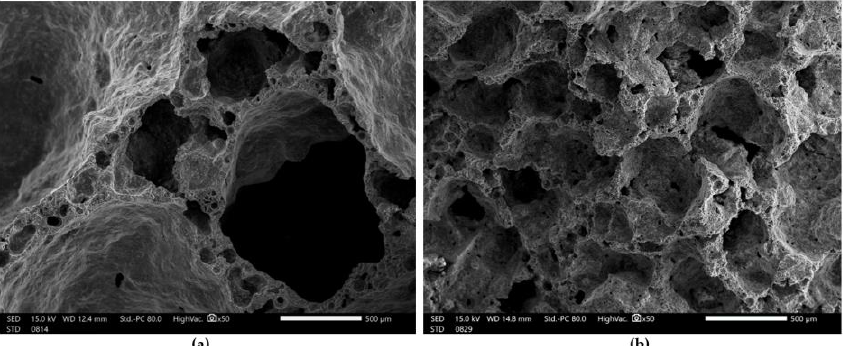
Figure 6. SEM images of foamed geopolymer materials at 50× magnification: ( a ) Mix 1; ( b ) Mix